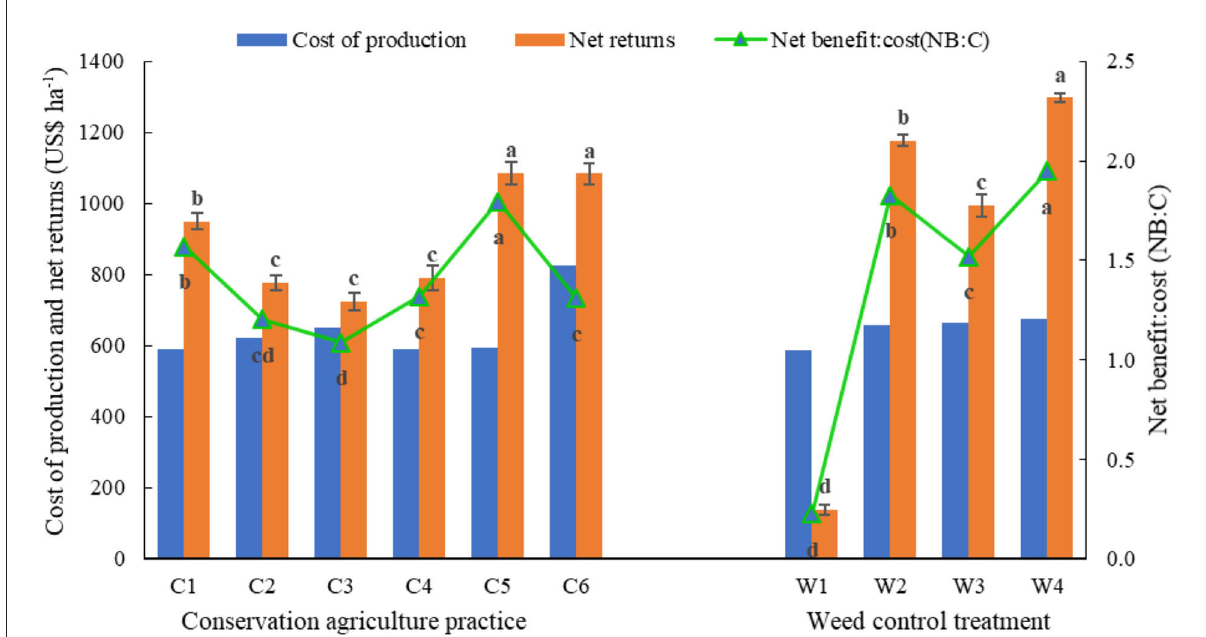
FIGURE4 Benefit–cost economics of rice cultivation as influenced by CA and weed control practices (mean of two years). Mean having different lowercase letters on the vertical bars are significantly different at